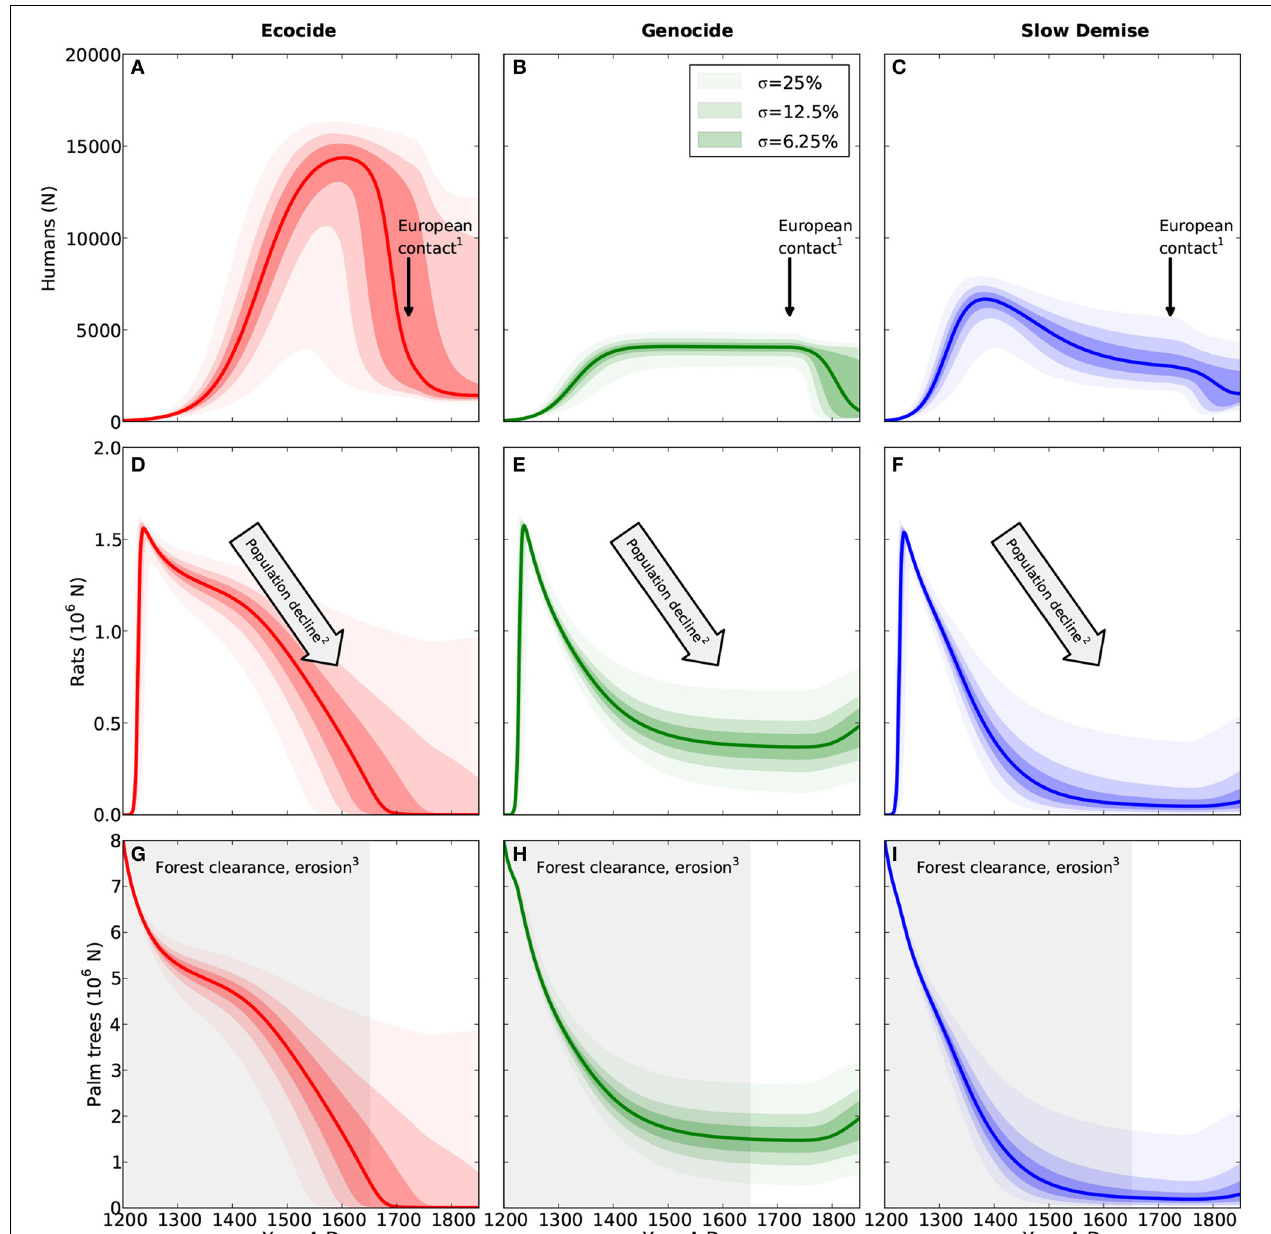
FIGURE 1 | Population dynamics of humans (A–C), rats (D–F), and palm trees (G–I). Results are shown for the three different scenarios ecocide (red), genocide (green), and slow demise (blue). Solid lines present the standard run of the respective scenario (cf. Table 1 for parameter values) and the shaded areas indicate the 10 (lower range) and 90% (upper range) percentile of an ensemble of 10000 simulations with perturbed parameter sets. Dark, intermediate, and light shadings indicate three ensembles with different standard deviations ( σ = 6.25, 12.5, and